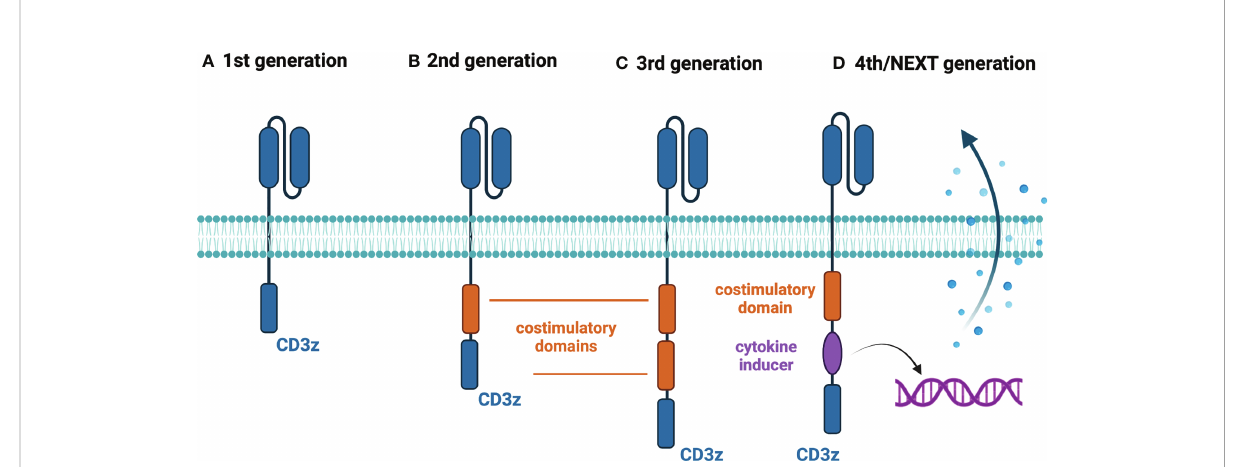
FIGURE 1 Generations of CAR-T cells. (A) First-generation CAR-T cells – equipped with an extracellular antigen-recognizing domain combined with intracellular CD3z accounting for signal transduction. (B) Second-generation CAR-T cells - equipped with an extracellular antigen-recognizing domain combined with two intracellular domains: CD3z and an additional costimulatory domain (e.g., CD28 or 4-1BB). (C) Third-generation CAR-T cells - equipped with an extracellular antigen-recognizing domain combined with three intracellular domains: CD3z and two additional costimulatory domains. (D) Fourth/Next-generation CAR-T cells – a diversi fi ed group of CAR-T constructs embracing armored CAR-T cells, cytokine-expressing CAR-T cells (illustrated above), switchable CAR-T cells, and universal CAR-T cells. Created with